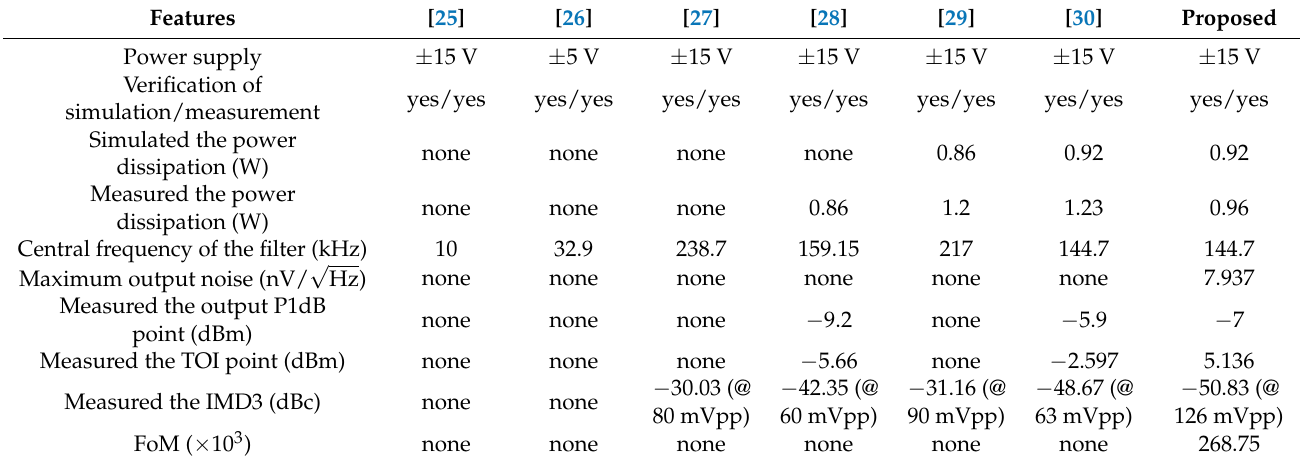
Table 2. Characteristic comparisons of the proposed biquad with the biquads previously reported in the literature [25–30].